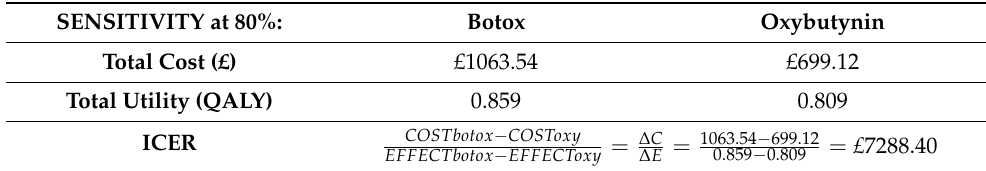
Table 5. Sensitivities of Botox and oxybutynin at 80%. SENSITIVITY at 80%: